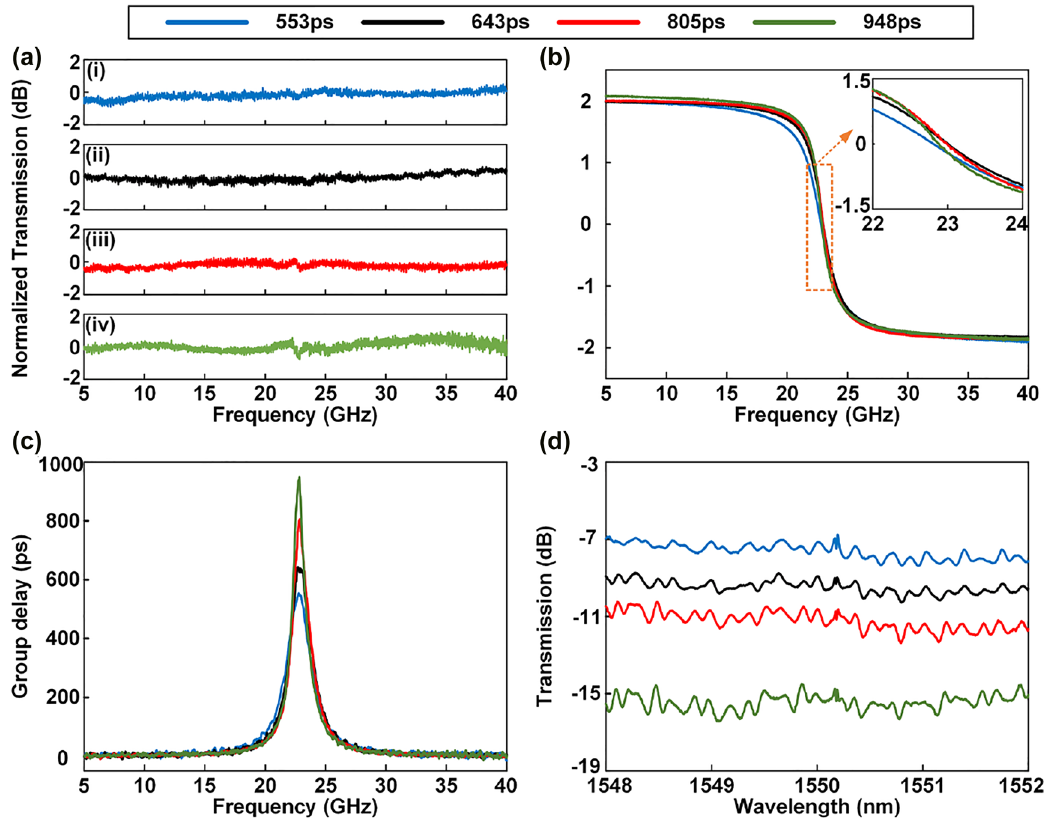
, H , H , H , H , H , and H are changed. 2 4 5 6 7 8 10